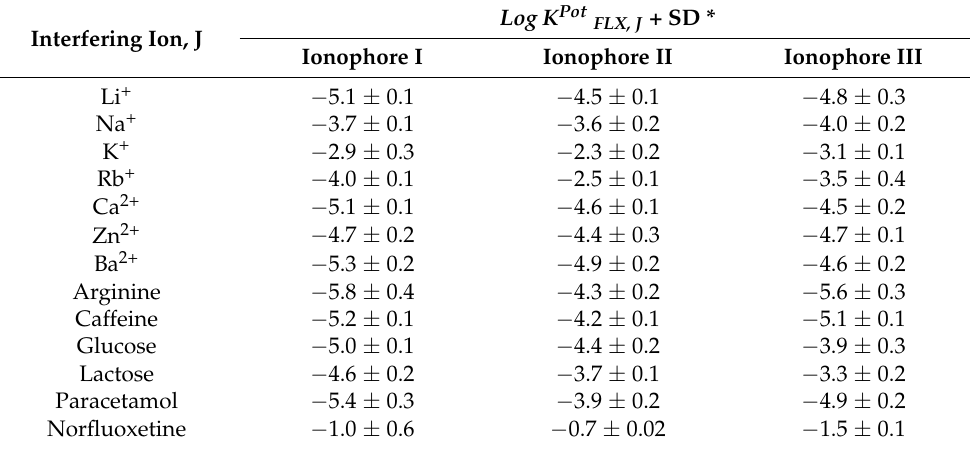
Log K Pot FLX, J + SD